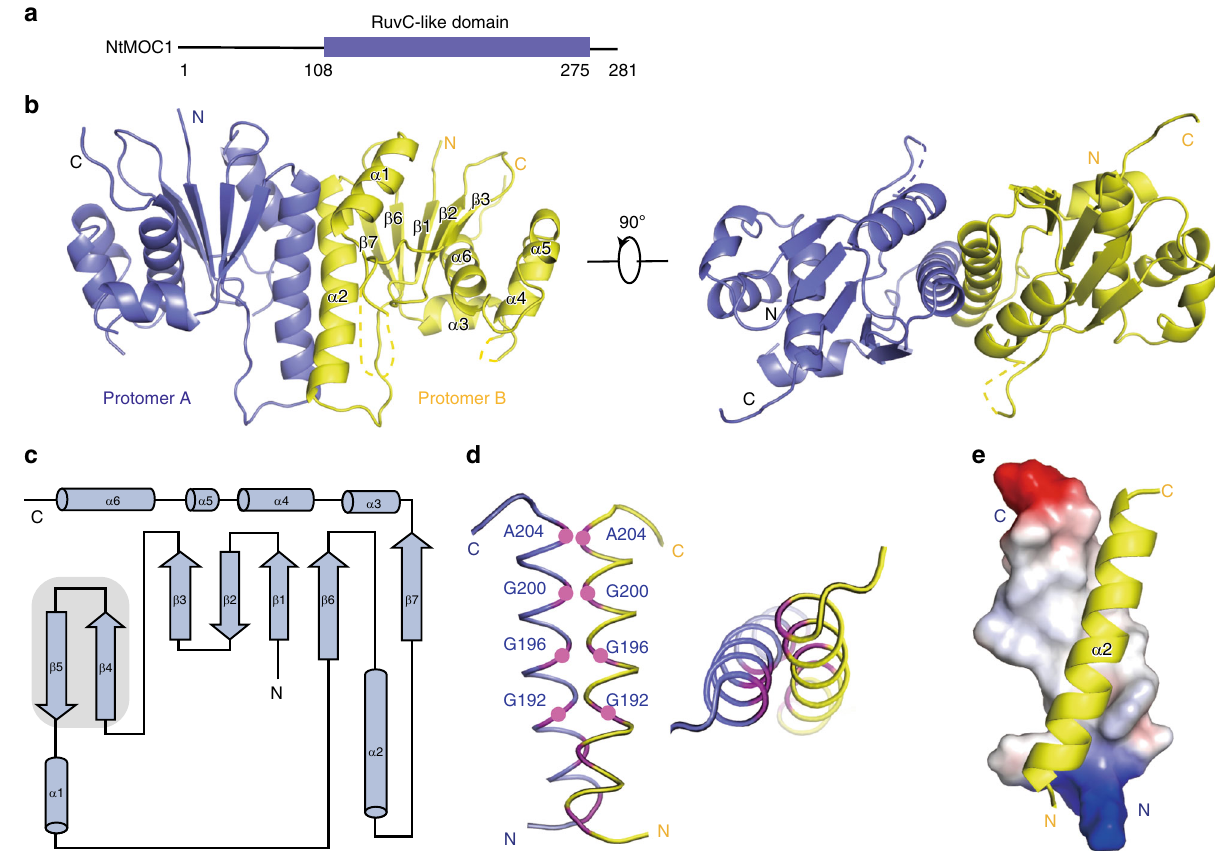
Fig. 2 Crystal structure of apo NtMOC1. a Schematic domain structure of NtMOC1. The C-terminus (residues 108-275) is the RuvC-like domain, the structure of which was determined in this study. b Two perpendicular views of the overall structure of apo NtMOC1. Secondary structural elements are labeled in protomer B. Dashed lines indicate residues with missing electron density. c Topological diagram of the NtMOC1 protomer. Secondary structure elements are labeled as in a . Two β -sheets ( β 4 – β 5) observed in the complex structure are shaded in gray. The electron density of this segment is missing in the apo structure. d Residues with small side chains constitute the dimer interface. e Dimer interface of the helix bundle. α 2s from protomers A and B are shown in the electrostatic surface potential and in the yellow cartoon illustration, respectively. The blue and red colors indicate positively and negatively charged residues, and white regions indicate hydrophobic